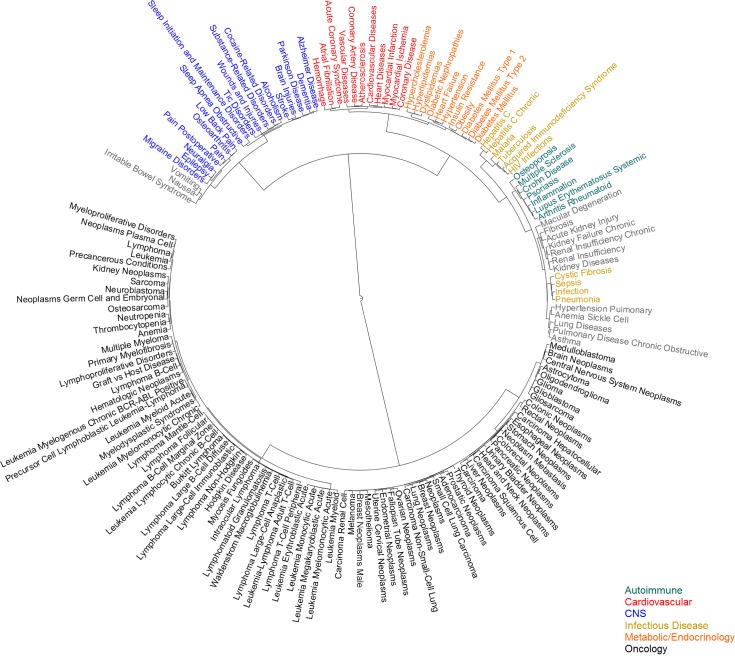
Drug-centric hierarchical clustering of diseases.One hundred fifty-six diseases from the Clinical dataset were clustered using a distance metric based on the drugs adopted by each disease. Several clusters were colored based on the class of diseases that prevailed in the cluster: autoimmune/inflammation (blue-green), cardiovascular (red), CNS (blue), infectious disease (gold), metabolic/endocrinology (orange), oncology (black).